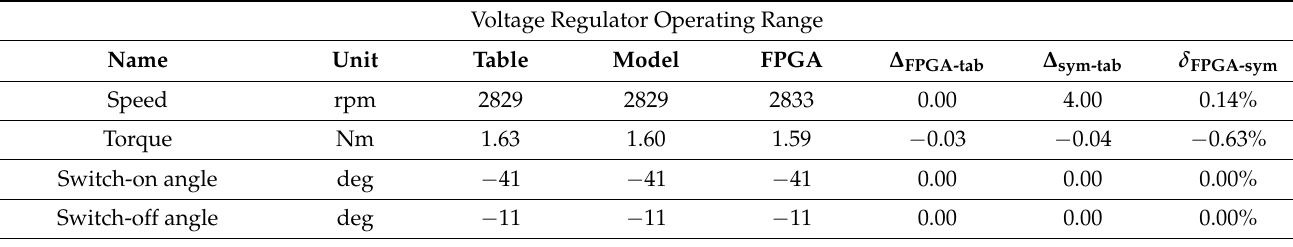
Table 6. Comparison of tabulated values, simulation and calculations results in an FPGA